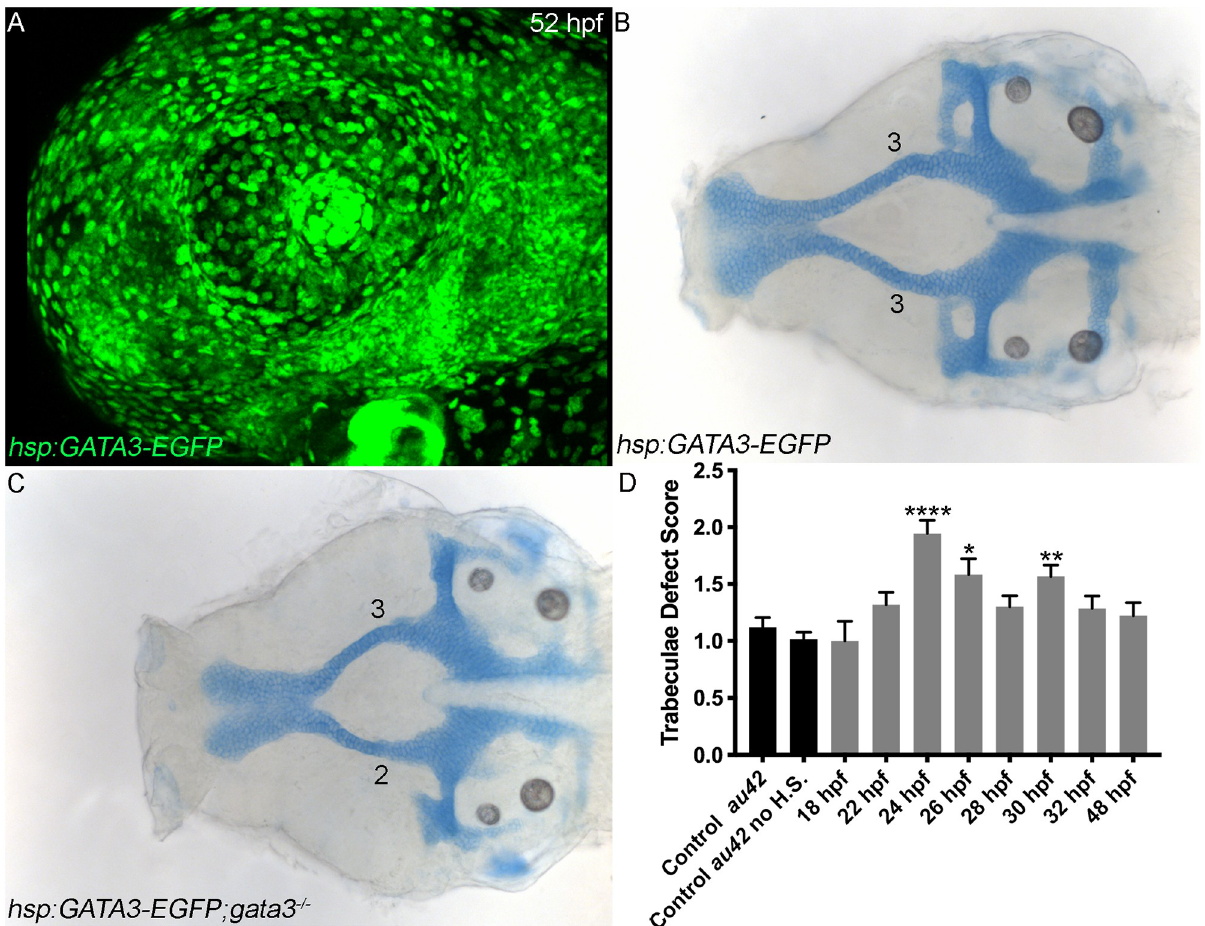
Fig 4. Gata3 function is required during early palatogenesis. (A) Embryo carrying the hsp : GATA3-EGFP transgene heat shocked at 48–49 hpf and imaged at 52 hpf expressing human GATA3 in every cell. (B) Flat mount of a cartilage stained 4 dpf hsp : GATA3-EGFP;gata3 +/+ embryo that was heat shocked at 24 hpf with no resulting visible malformations. (C) Flat mount of a cartilage stained 4 dpf neurocranium carrying hsp : GATA3-EGFP ; gata3 au42/au42 . The mutant embryo was heat shocked at 24 hpf and resulted in a substantial rescue of the trabeculae phenotype. (D) Graph depicting quantification of mutant gata3 au42 phenotype scores at different heat shock time points. Trabeculae phenotype is rescued significantly by hsp : GATA3-EGFP at 24–26 hpf and also at 30 hpf. A one-way ANOVA was performed followed by Dunnett’s multiple comparisons test, gata3 au42/au42 control was compared to all other conditions.